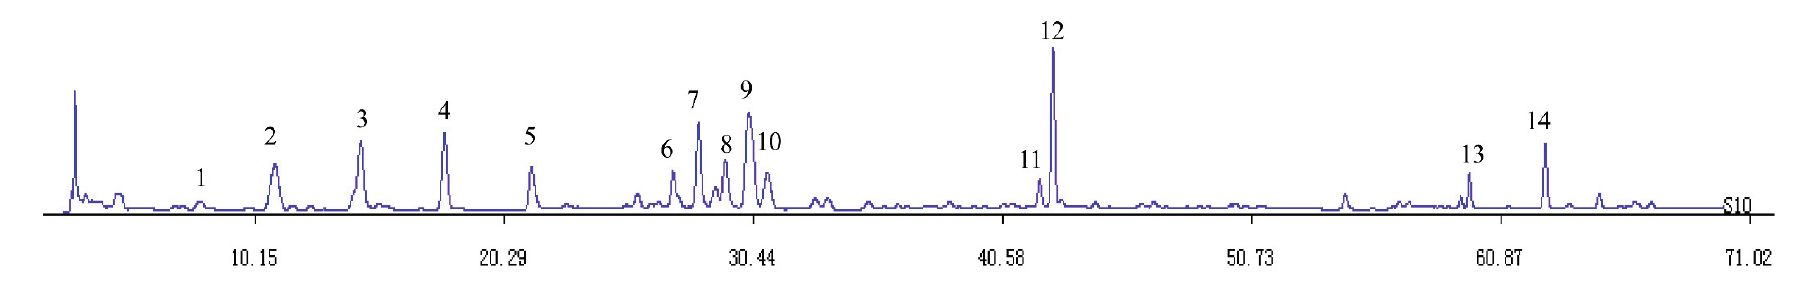
Figure 2. The reference atlas from the 10 chromatograms of